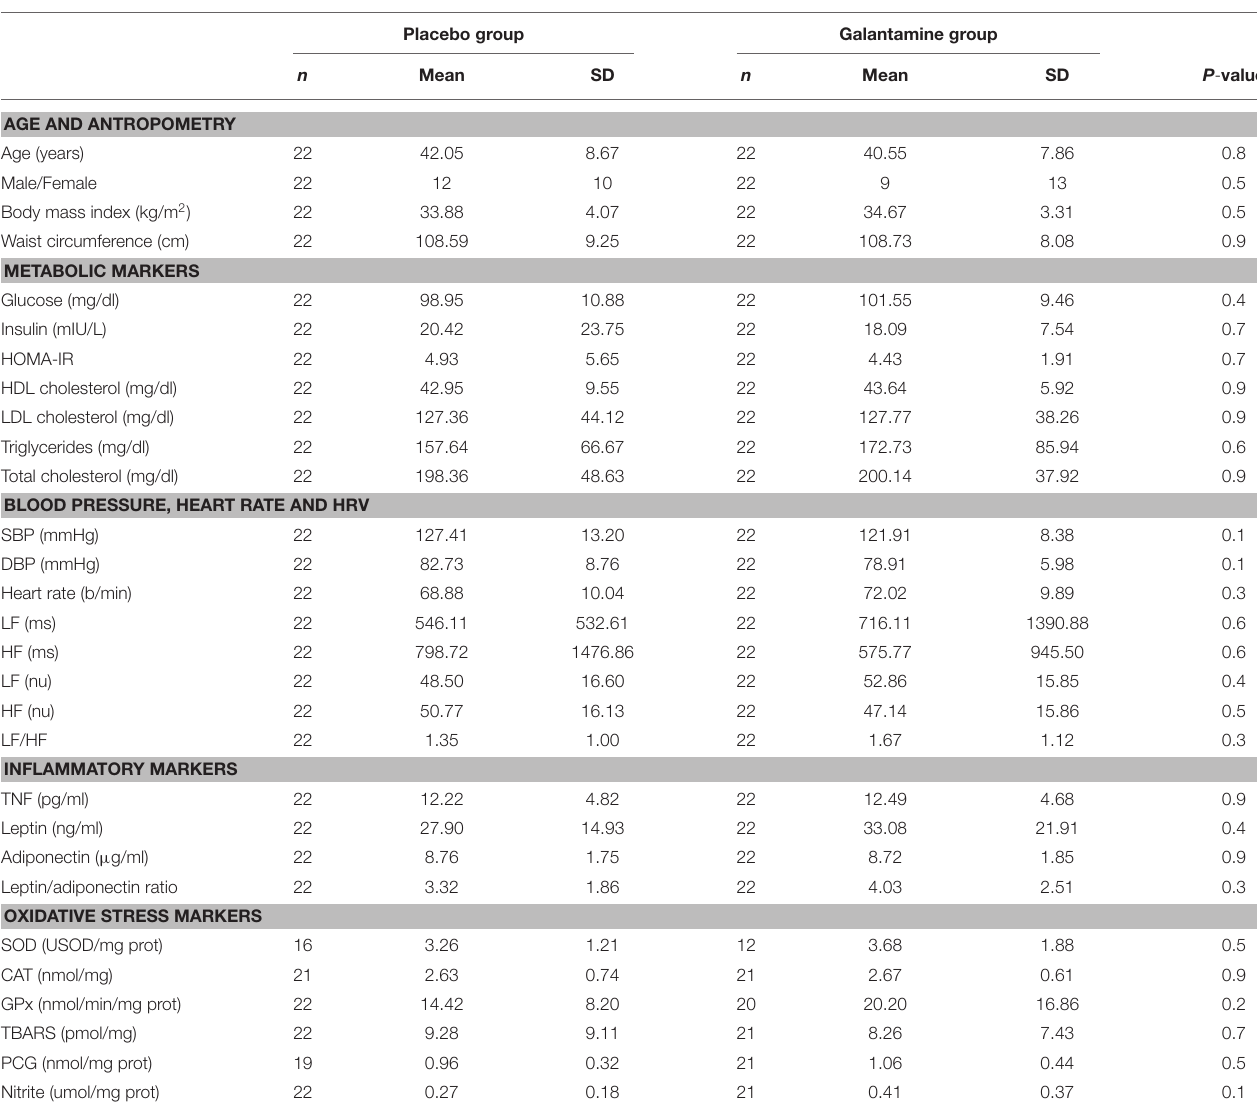
TABLE 1 | Baseline characteristics.